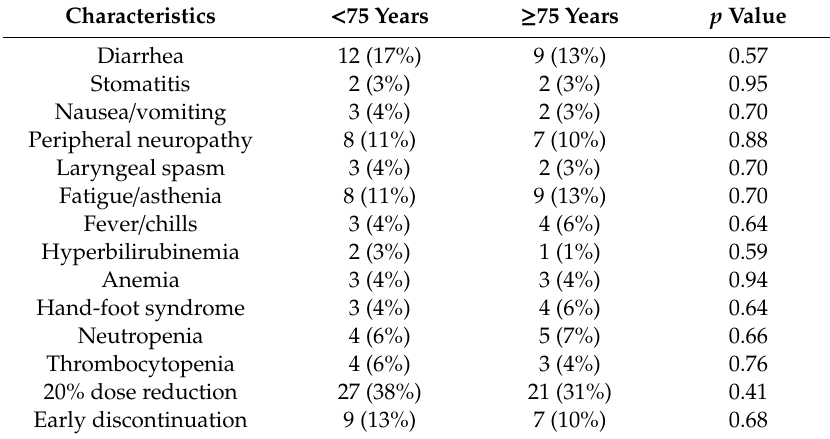
Table 2. Frequency of chemotherapy intolerance and grade 3–4 toxicity per patient